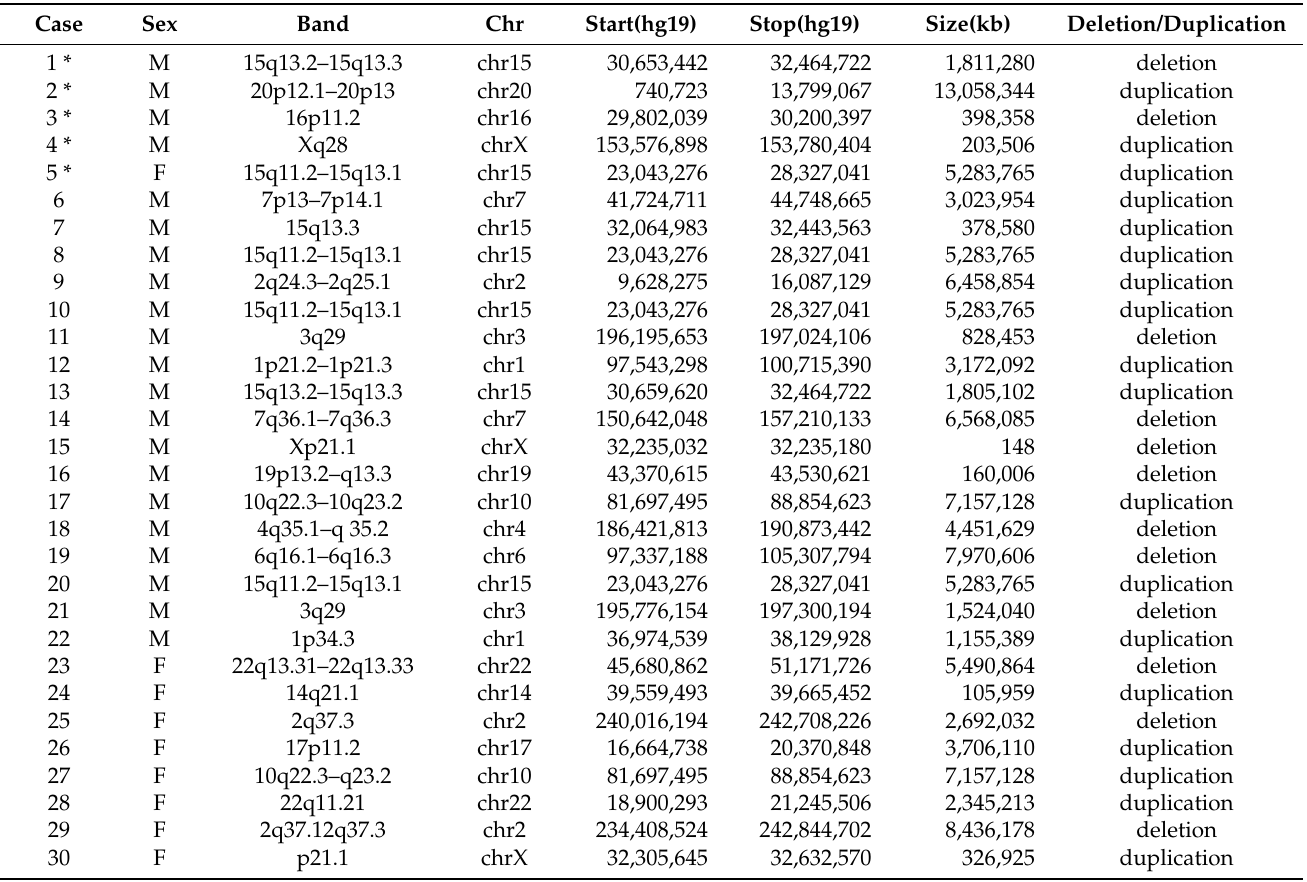
Table 2. CNVs identified from ASD patients from